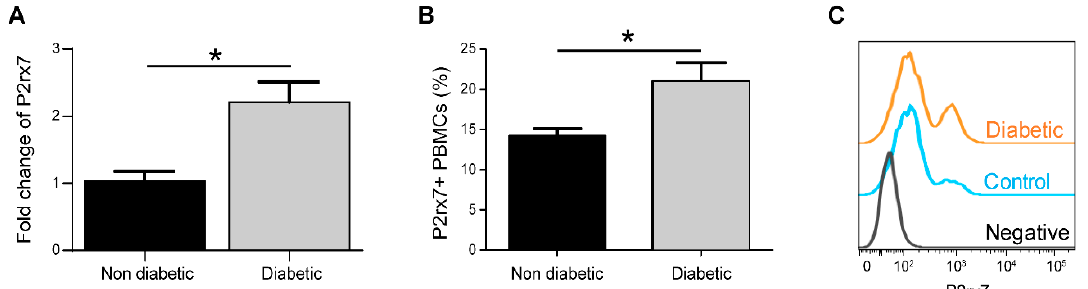
Figure 1. P2rx7 expression is upregulated in diabetic animals. Three-month old mice were rendered diabetic by streptozotocin (STZ) injections. One month after the onset of diabetes, blood was collected for flow cytometry and retinas were dissected and processed for RNA extraction and qRT-PCR. ( A ) Relative P2rx7 expression in non-diabetic and diabetic retinas. ( B ) Average percentage of P2rx7 + peripheral blood mononuclear cells (PBMC). ( C ) Representative histogram showing P2rx7 + cells. Student’s t test, * p < 0.05, n = 4–8.